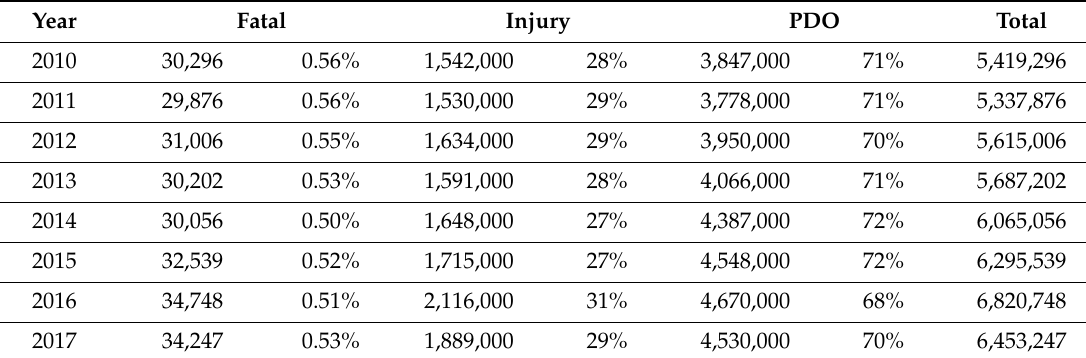
Figure 5. Relative crash number (with respect to 2010). Table 3. Annual crash numbers and ratios of three crash types.